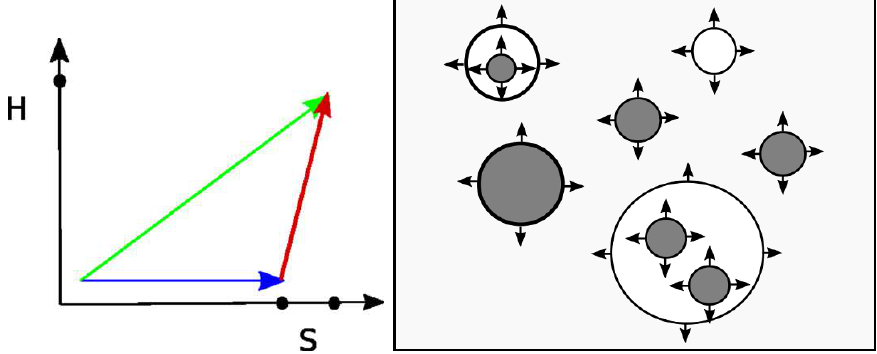
Figure 2 . Left: the possible phase transitions for the case where the Standard Model is extended by a singlet. If the phase transitions are separated then only either bubbles for the blue and red transitions form. If the phase transitions are overlapping the green can form too. Right: example of the nucleation of different bubble species when an overlapping two step phase transition occurs. The background is the vanilla vacuum and different coloured bubbles represent the vacua A and B, corresponding to minima which are deeper than the vanilla